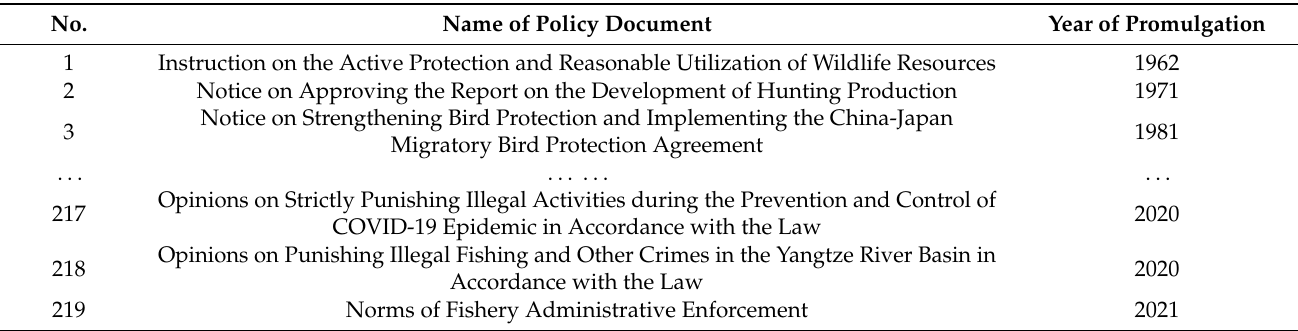
Table 1. China’s Wildlife Management Policies